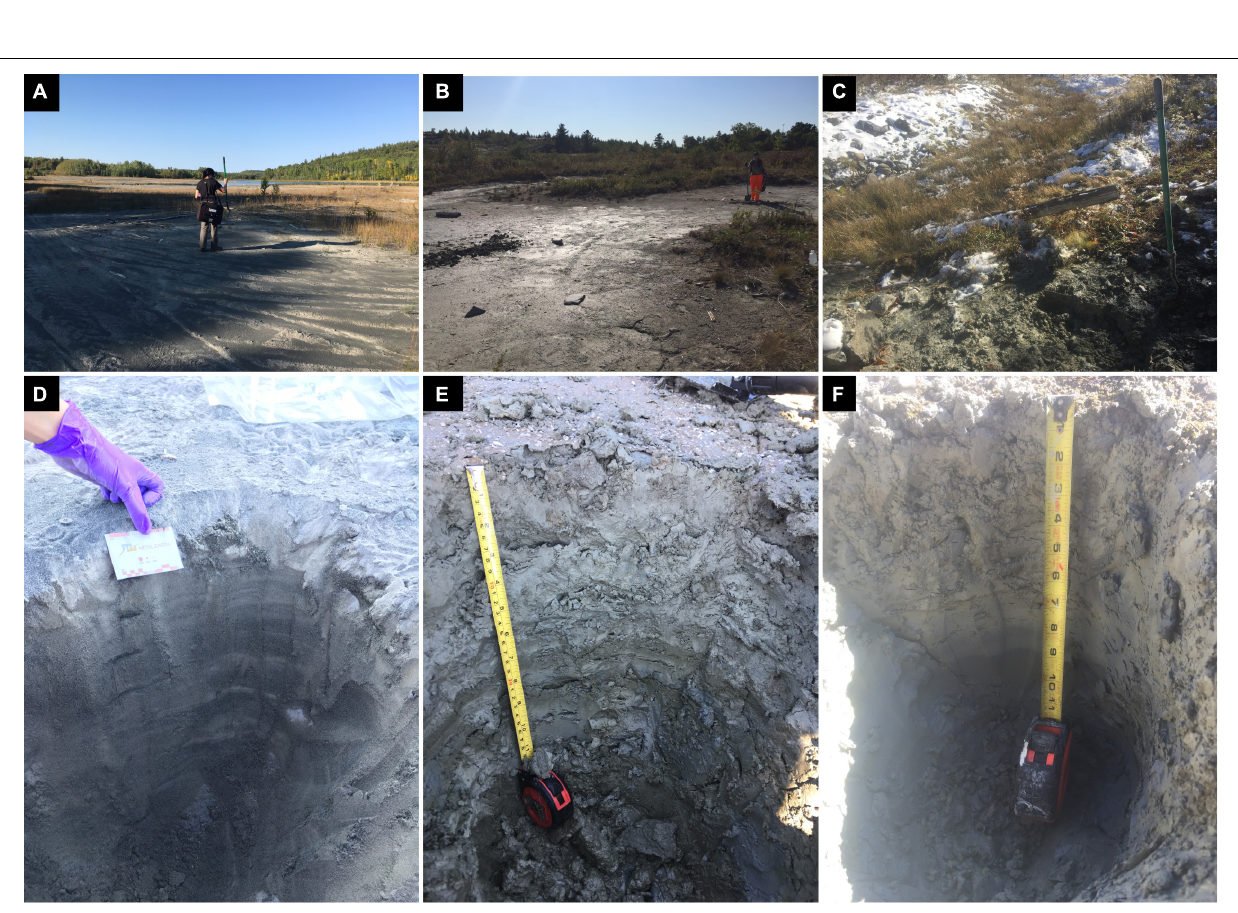
Frontiers in Microbiology |